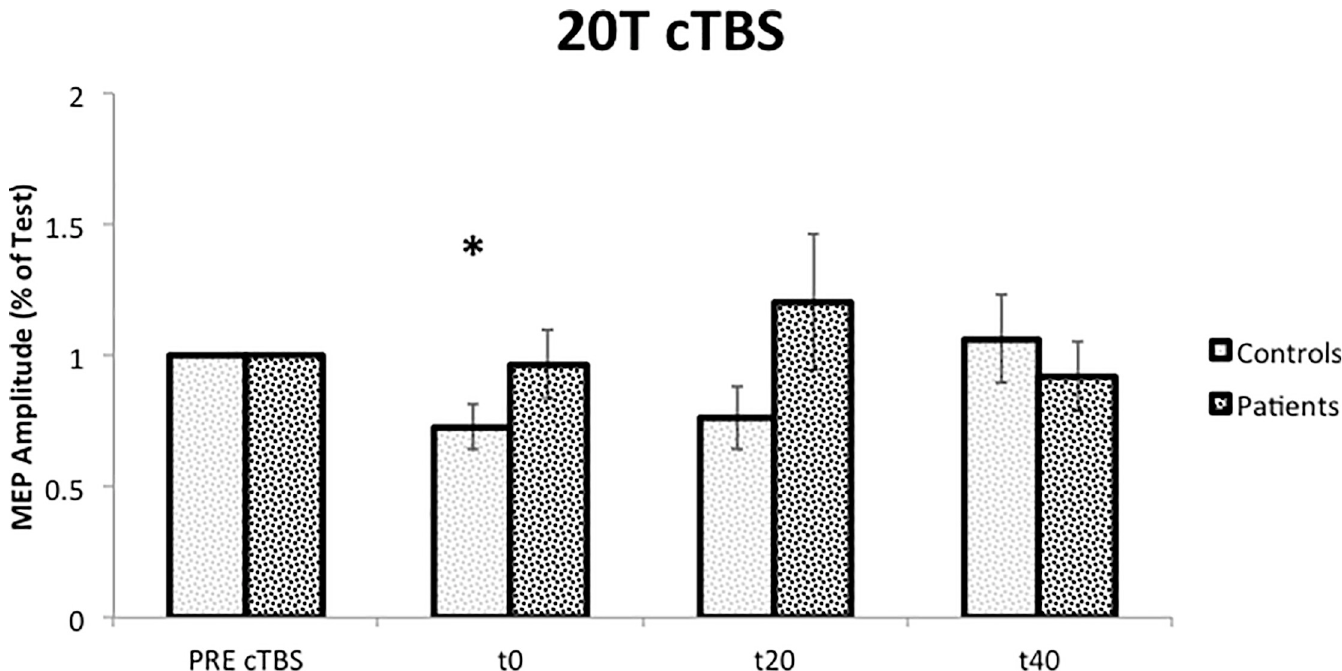
Fig 4. Effects of cerebellar cTBS on cortical excitability (MEP protocol). 20T: 20 Test. PRE: before cTBS; t0: immediately after cTBS; t20: 20 minutes after cTBS; t40: 40 minutes after cTBS. � : P < 0.05 (difference, in control group, compared to the value obtained before the cTBS). Error bars represent the standard error.